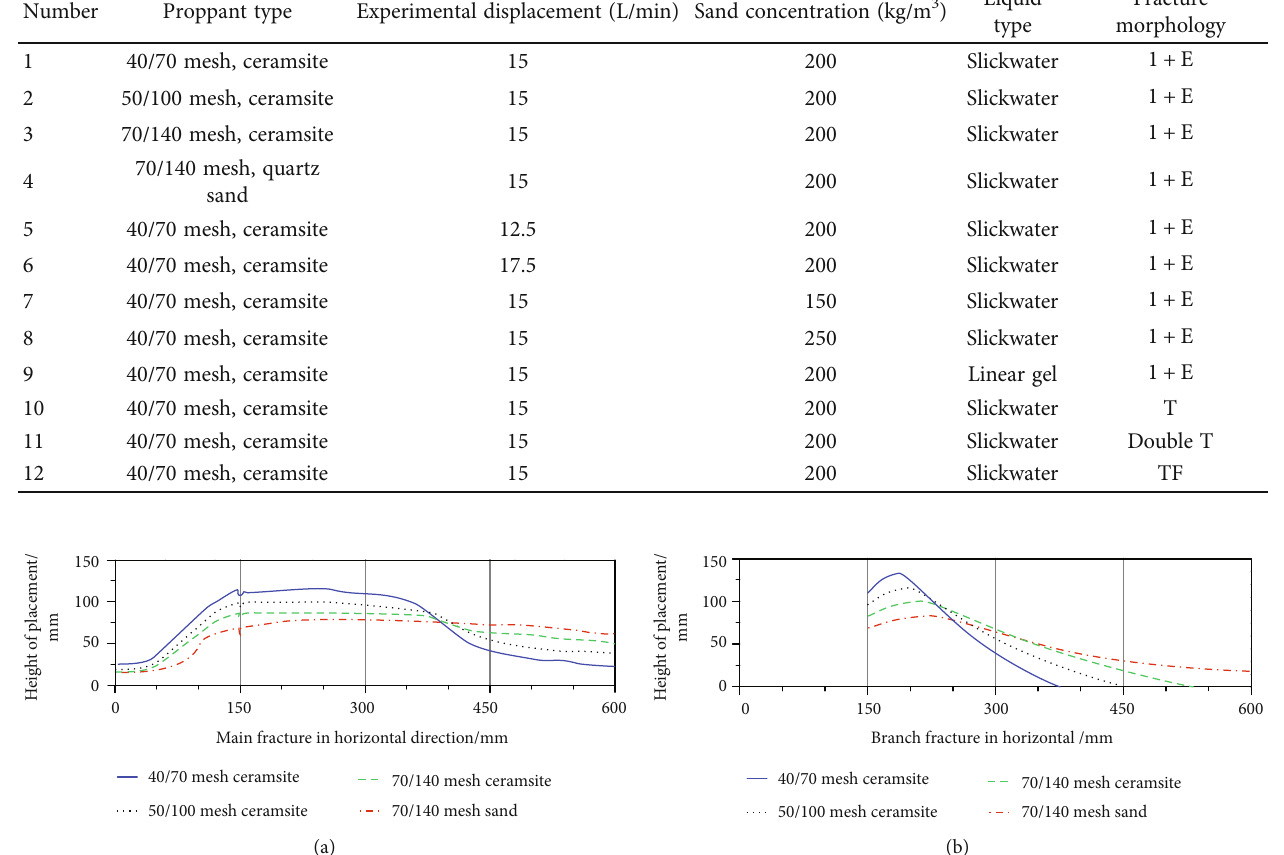
Figure 10: The transport characteristics of proppants in the main fracture (a) and branch fractures (b) with di ff erent proppant performances (granularity,